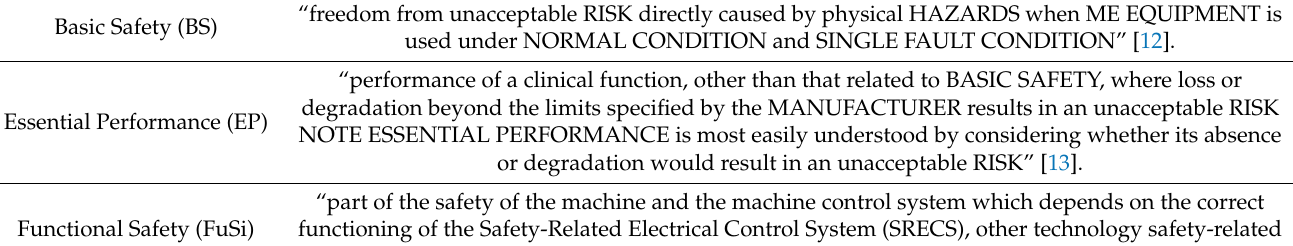
Figure 1. A Venn Diagram—Essential Performance (EP) & Functional Safety (FuSi) demonstrating the intersection between the clinical function of the instrument and the unacceptable risk associated with that instrument. Source: Authors own. Table 2. Definitions—Basic Safety, Essential Performance & Functional Safety. Table 2. Definitions—Basic Safety, Essential Performance & Functional